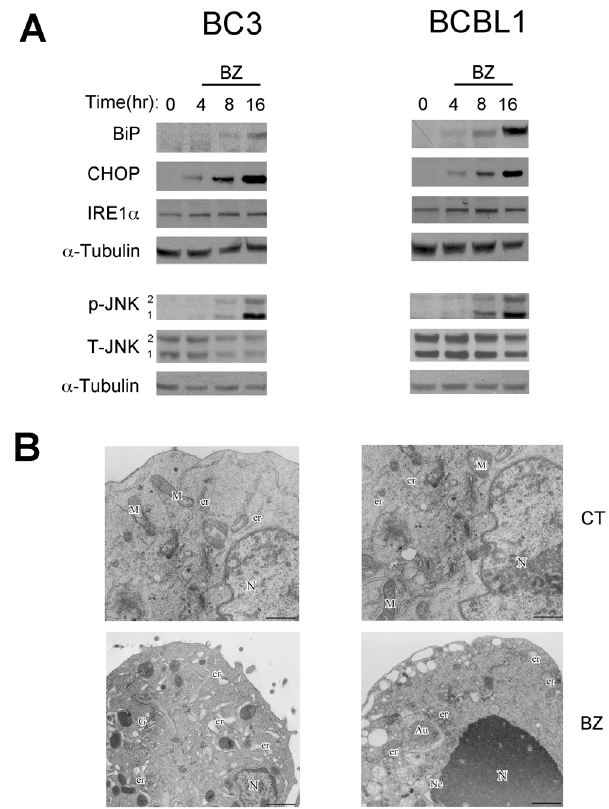
Figure 1. Bortezomib treatment induces ER stress in PEL cell lines. (A) Time course assay was performed on BC3 and BCBL1 cells treated with 20 nM of bortezomib (BZ) for 0, 4, 8, 16 hrs. Total cell lysates were prepared and immunoblotted with anti-BiP, anti-CHOP, anti IRE1 a , anti-phospho-JNK (p-JNK 1/2) and t-JNK antibodies. Anti- tubulin was assayed as protein loading control. (B) Electron microscopy (EM) analysis was performed on BC3 and BCBL1 cells treated with Bortezomib (20 nM) for 16 hrs (BZ). Cells showed several signs of ER stress compared to untreated control (CT). More apoptotic features such as nuclear (N) condensation were observed in BCBL1. Er (Endoplasmic reticulum), G (Golgi Apparatus), N (Nucleus), Au (Autophagosomes), Ne (Nuclear Envelope), M (Mitochondria). Bars: 1 m m. Results are representative of three independent experiments.